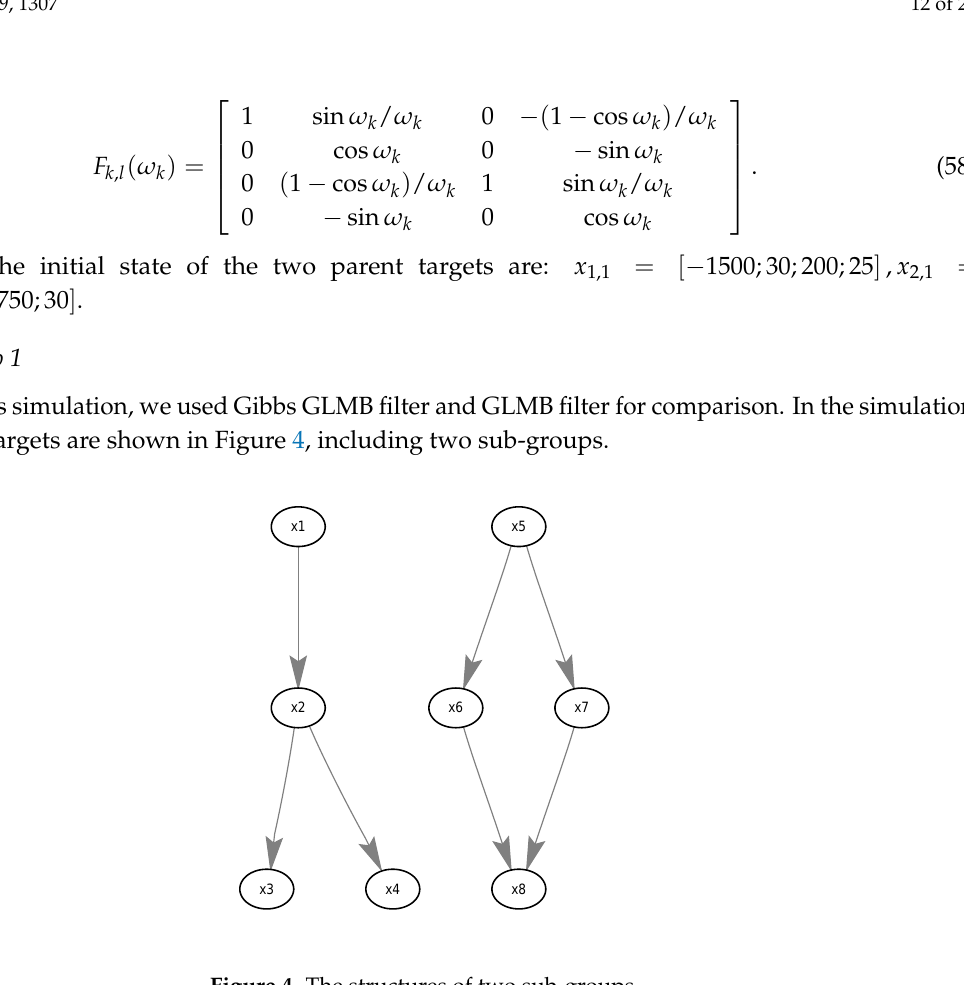
Figure 4. The structures of two